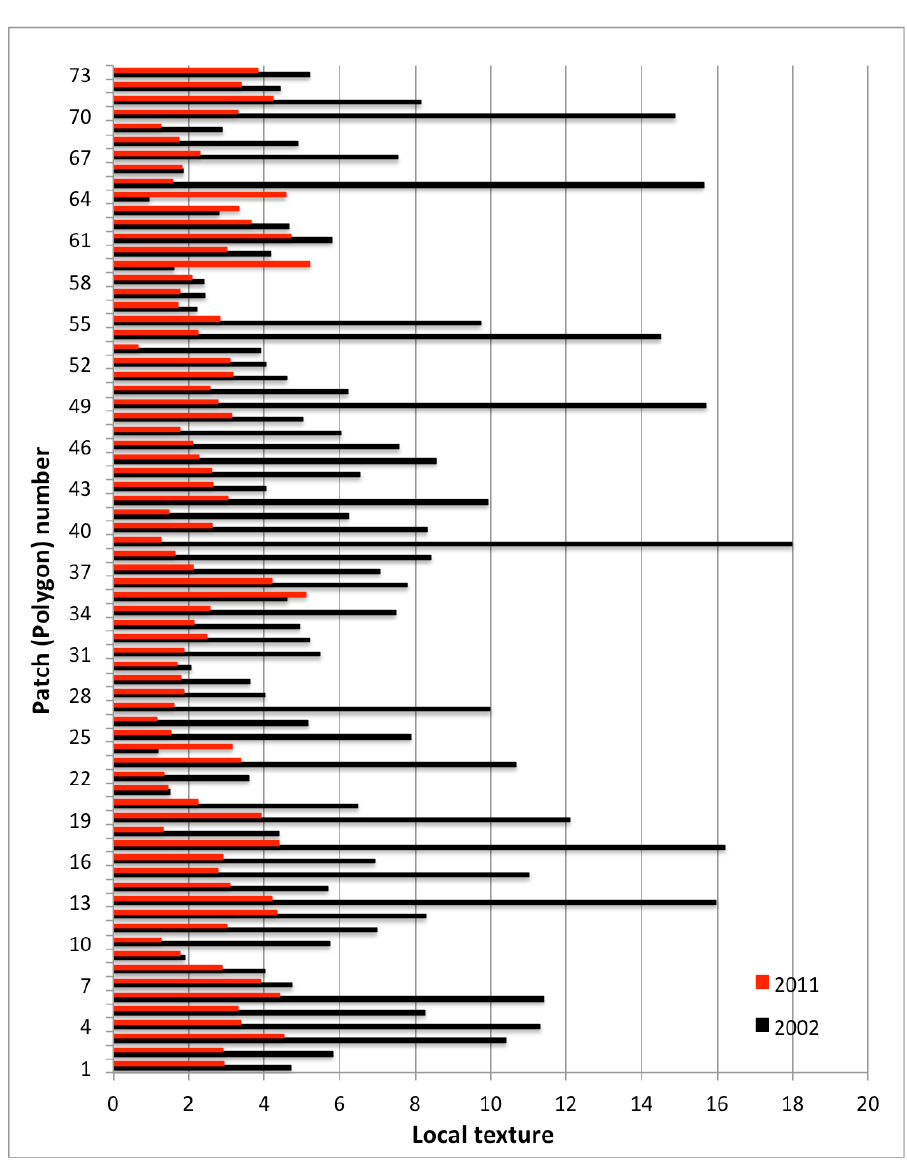
Figure 7. Quantitative changes in image texture by patch between 2002 and 2011 associated with rubber expansion. Here we use image local contrast as a form of image texture defined as the difference between pixel values in a local image window. In this context, the values in the X -axis correspond the variability of pixel values in each rubber plantation patch. The values in the Y -axis correspond to unique patch ID associated with a rubber plantation.